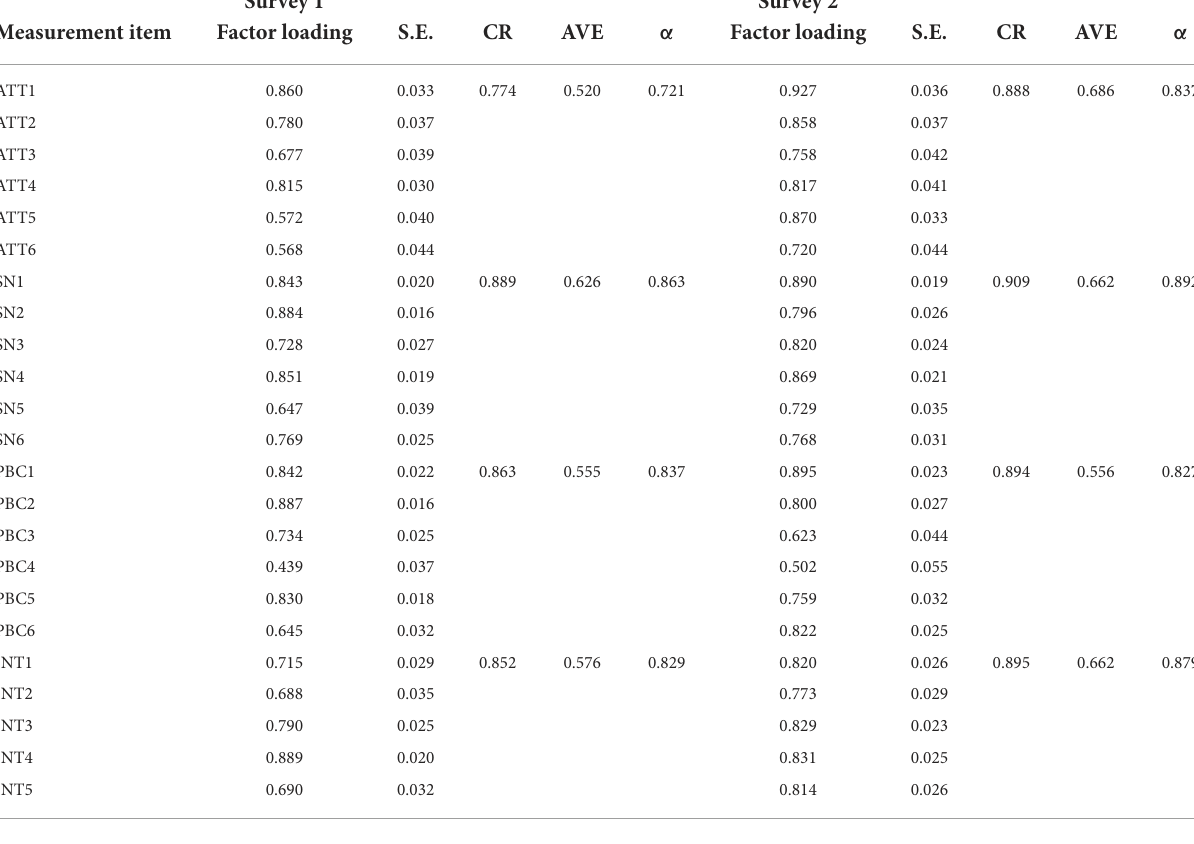
TABLE 5 Results of reliability and confirmatory factor analysis.